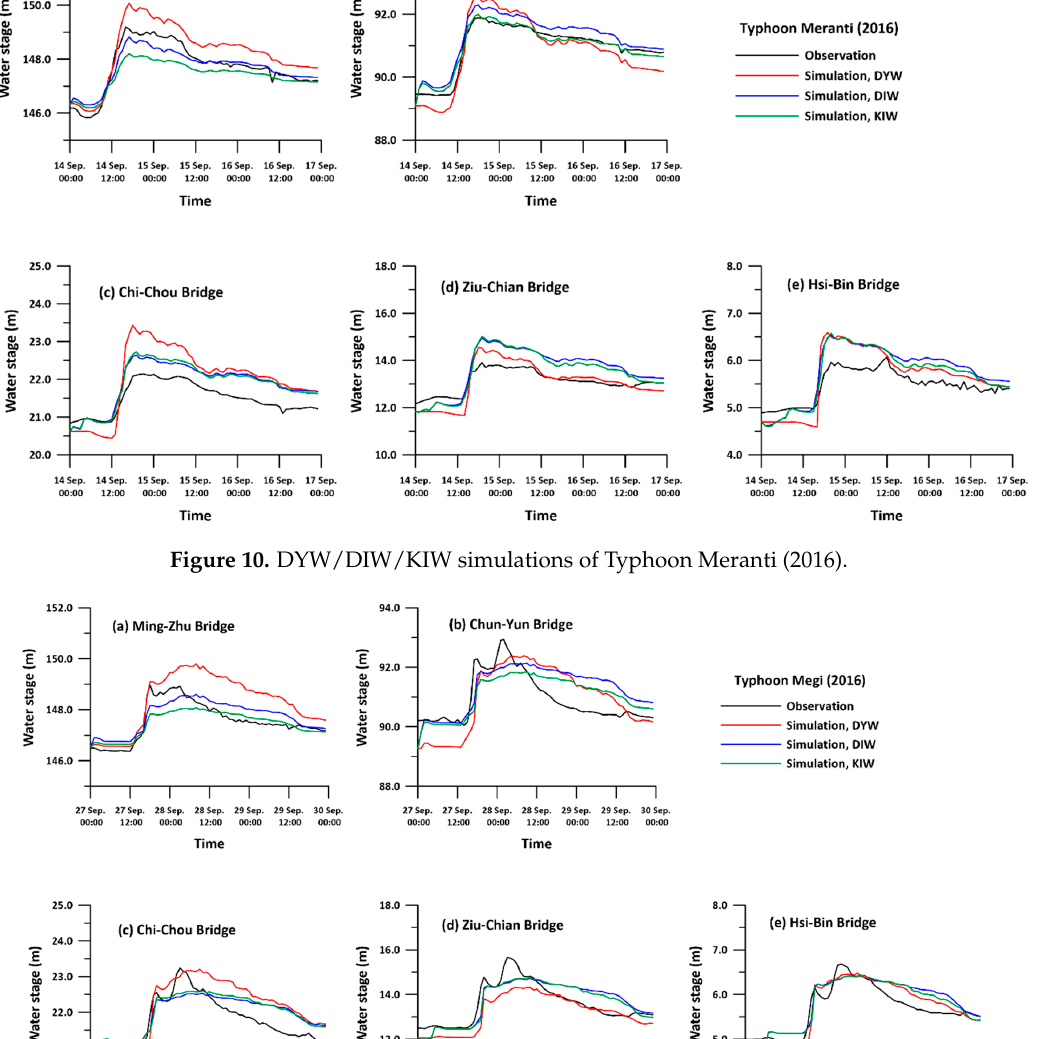
Figure 9. DYW/DIW/KIW simulations of Typhoon Dujuan (2015).